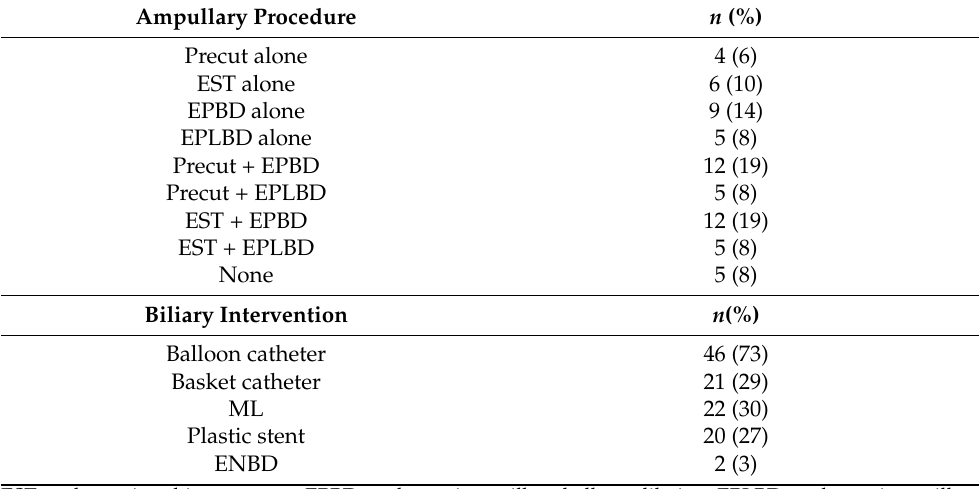
Table 3. Details of ampullary procedure and biliary intervention in initial BE-ERCP ( n = 63). Ampullary